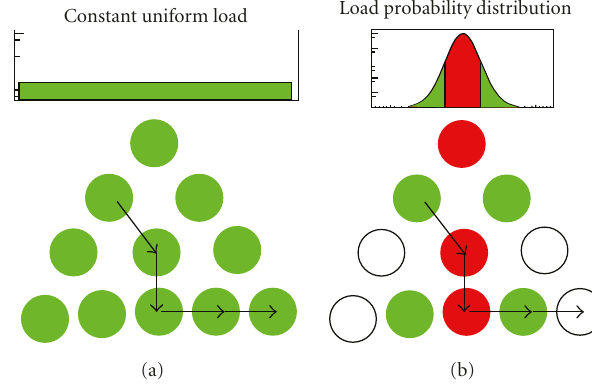
Figure 10: CPU load models for a tree-like topology: (a) uniform and (b) gaussian distributed.